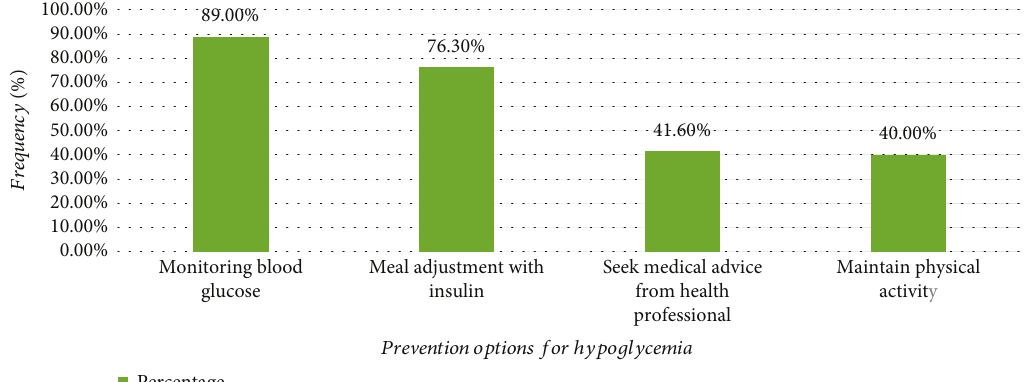
Figure 3: Prevention options of hypoglycemia among ambulatory T1DM patients attending the diabetes clinics of SPHMMC from June 01 to August 01, 2018.